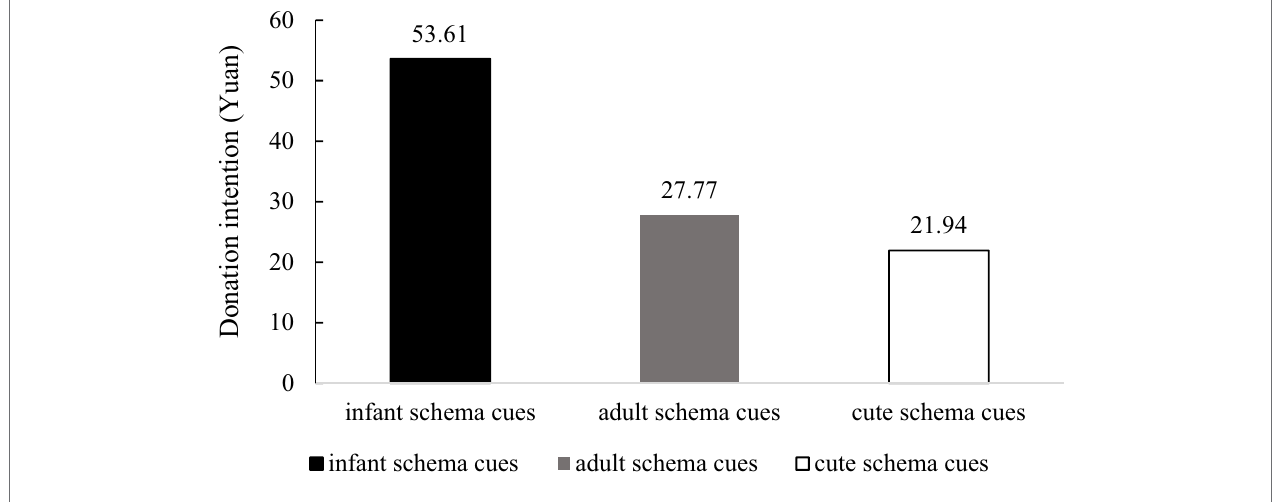
FIGURE 2 | Influence of infant schema cues on donation intention in Study 2.